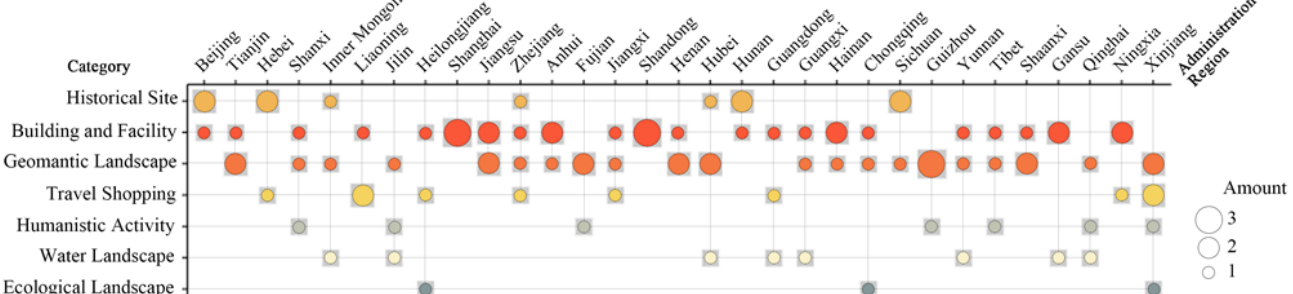
Figure 3. Regional distribution of NRTTC tourism resource categories.